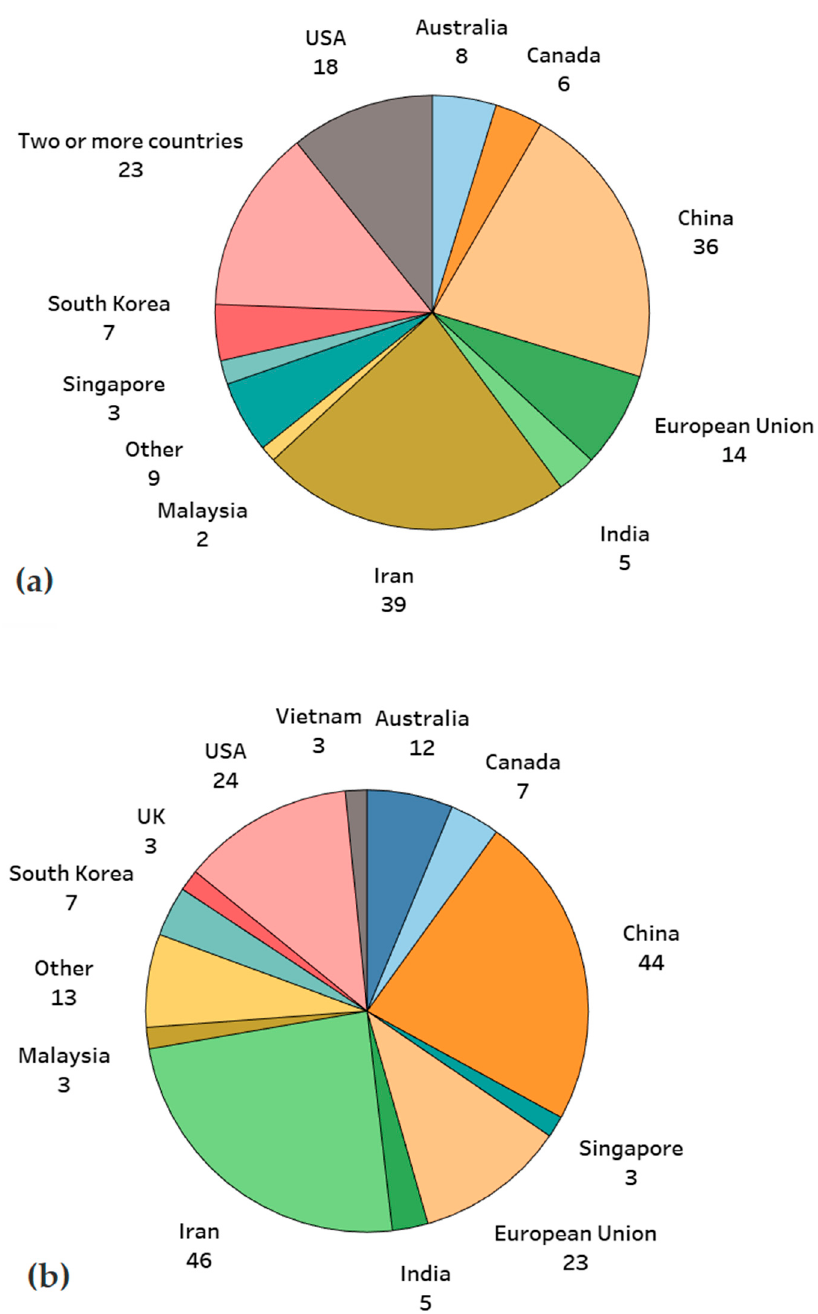
Figure 12. Number of articles by country or region of origin of the authors. ( a ) Accounting articles that have been written by researchers in two or more countries as a separate category. ( b ) Without accounting two or more countries as a separate category (an article may pertain to more than one category in this case). Self-elaboration.